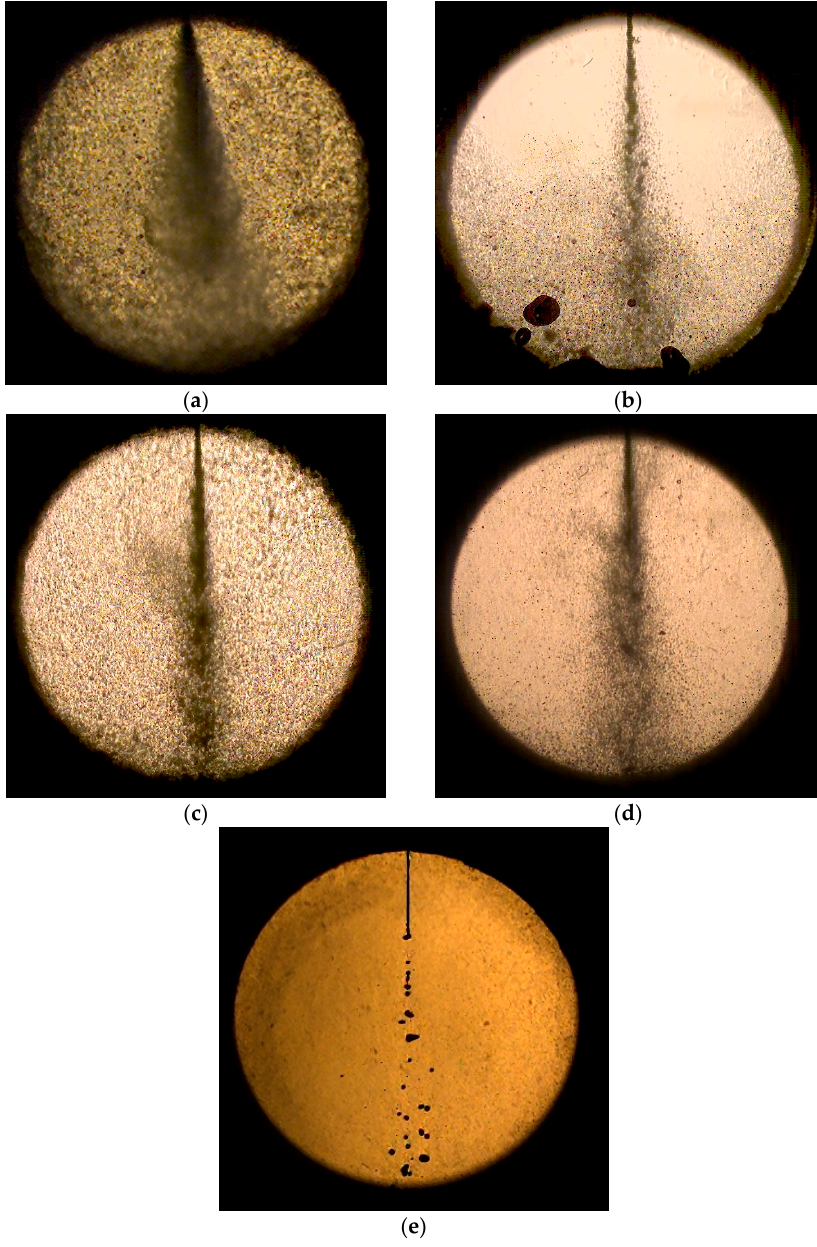
Figure 3. Effect of water fraction blended in water-LCO 2 mixture on spray pattern at 65/40 bar: ( a ) 0%; ( b ) 5%; ( c ) 25%; ( d ) 75%; and ( e ) 100% of water